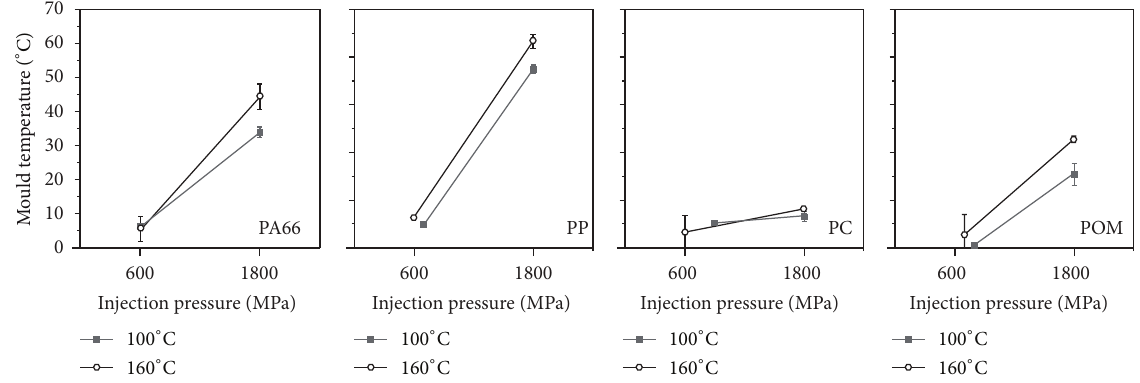
Figure 8: Flow length as function of injection pressure and mould temperature for the different